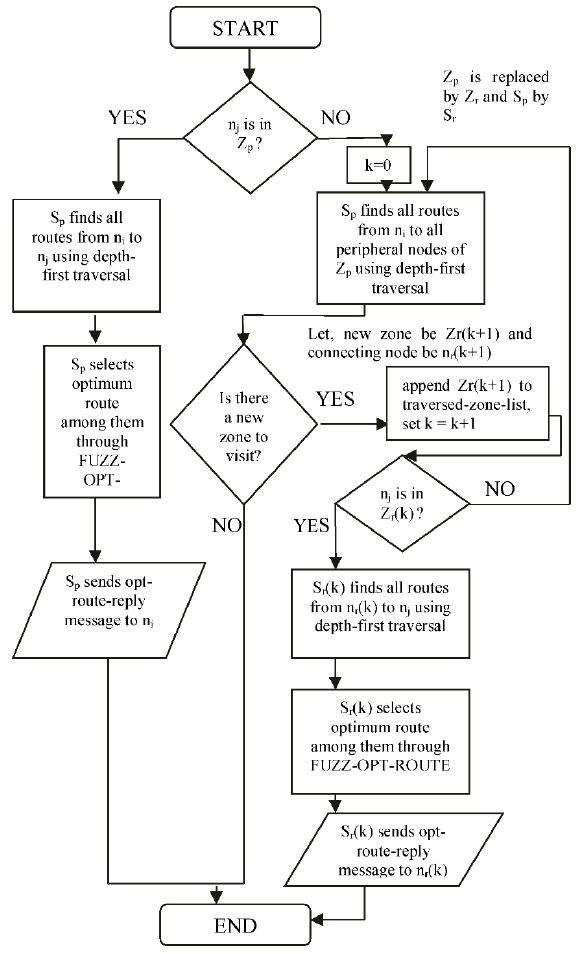
Figure 7. Node registration process.